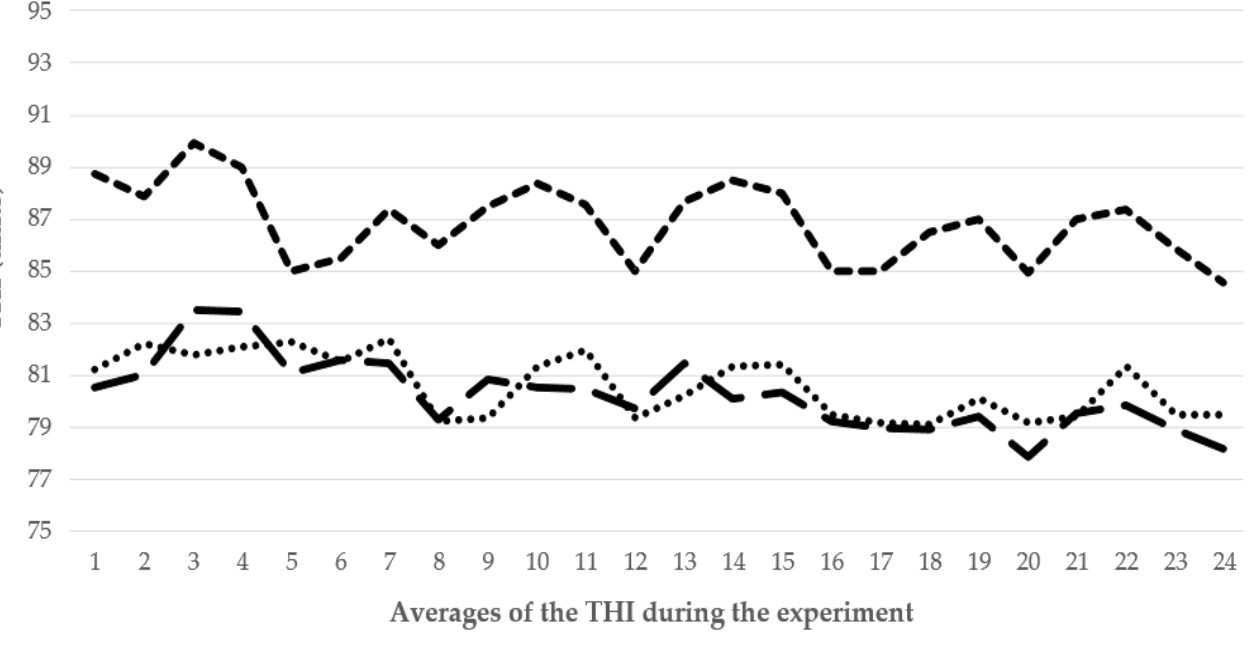
Figure 1. Temperature-humidity index (THI) values during the morning (dotted line), afternoon (line